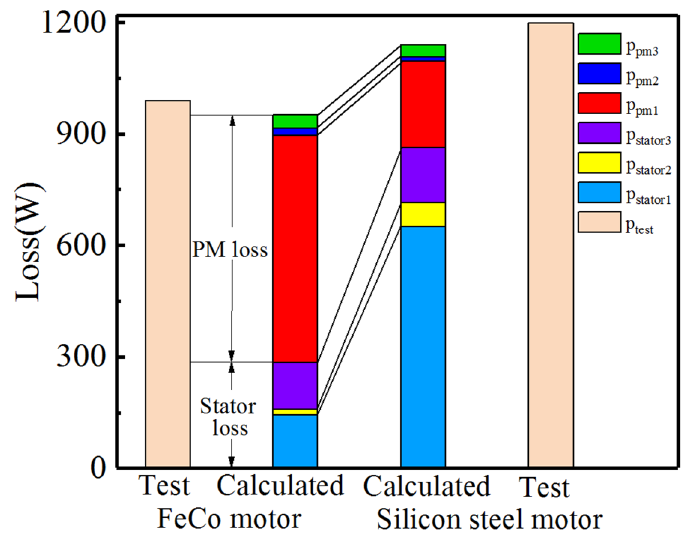
Figure 12. Motor loss separation and verification.